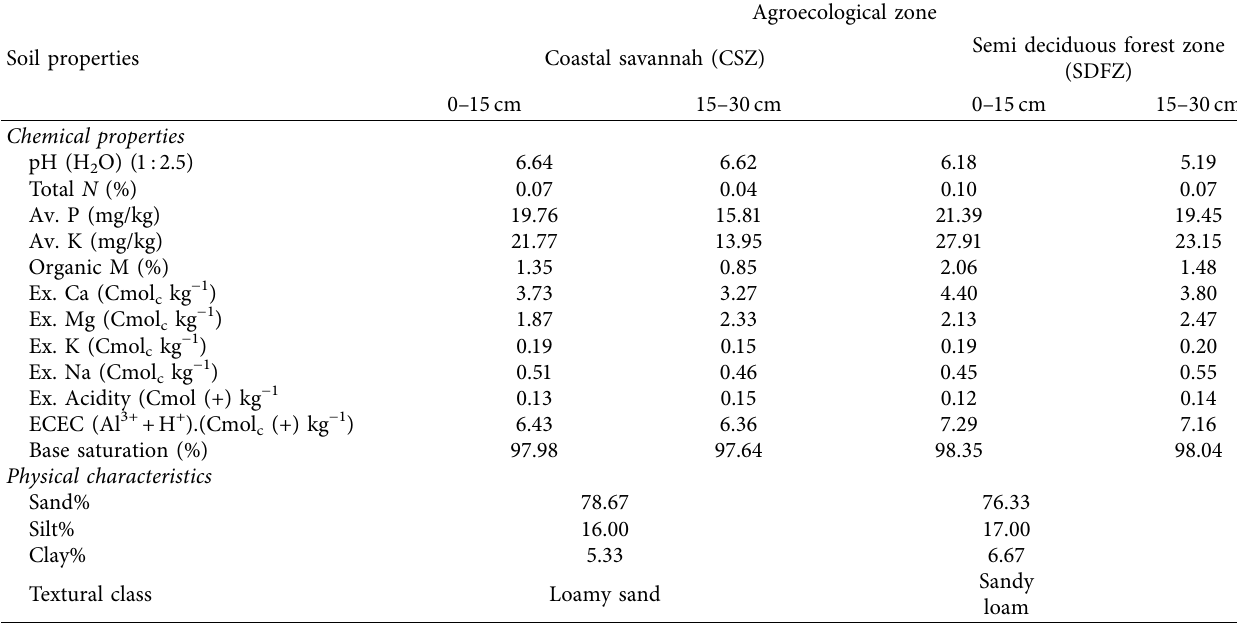
Table 4: Chemical and physical properties of soil at 0–15cm and 15–30cm soil depths of the coastal savannah and semi deciduous forest zones of Ghana used for the study.